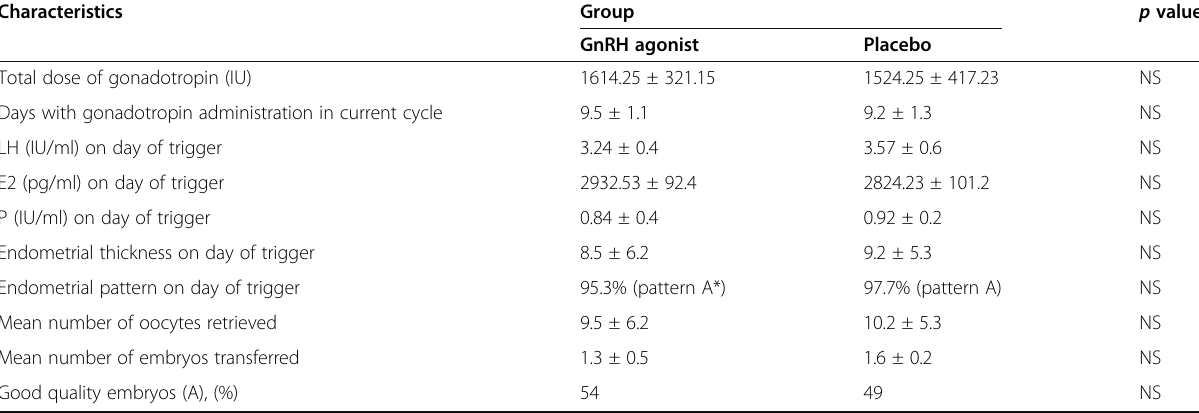
Table 1 Ovarian stimulation characteristics and outcomes of the studied groups